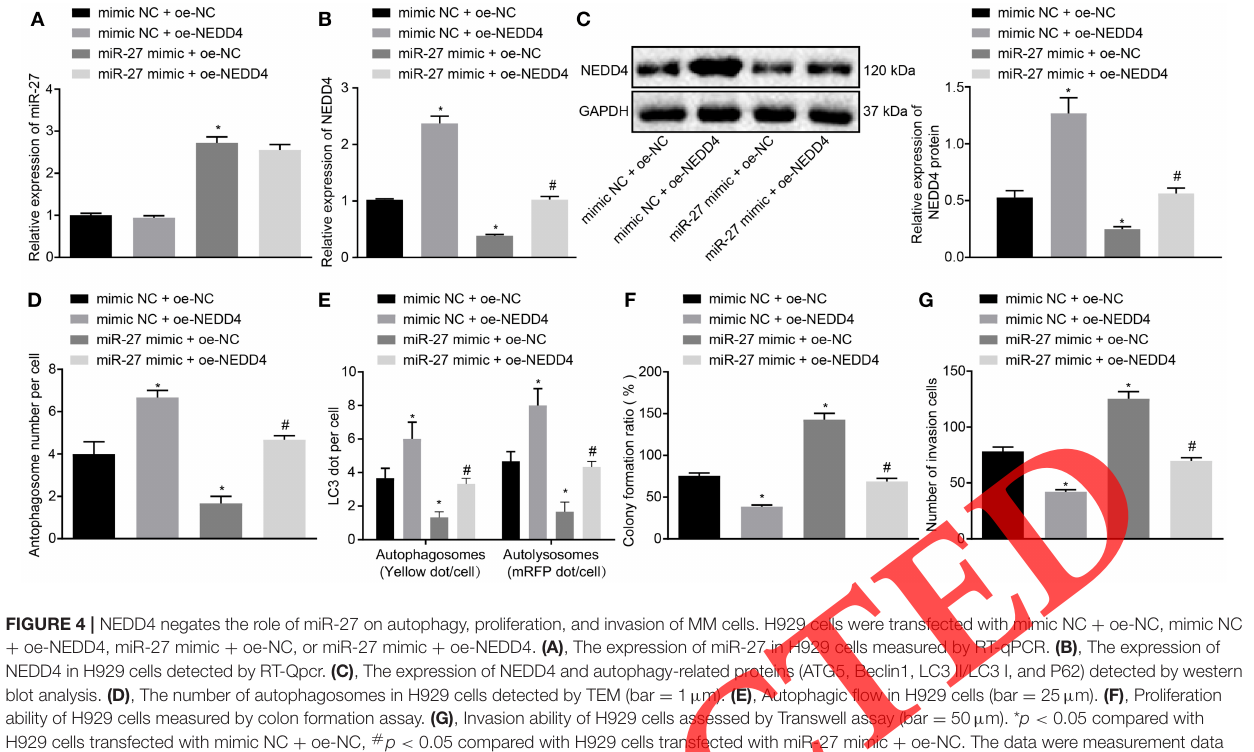
promoting cell autophagy but repressing cell proliferation and